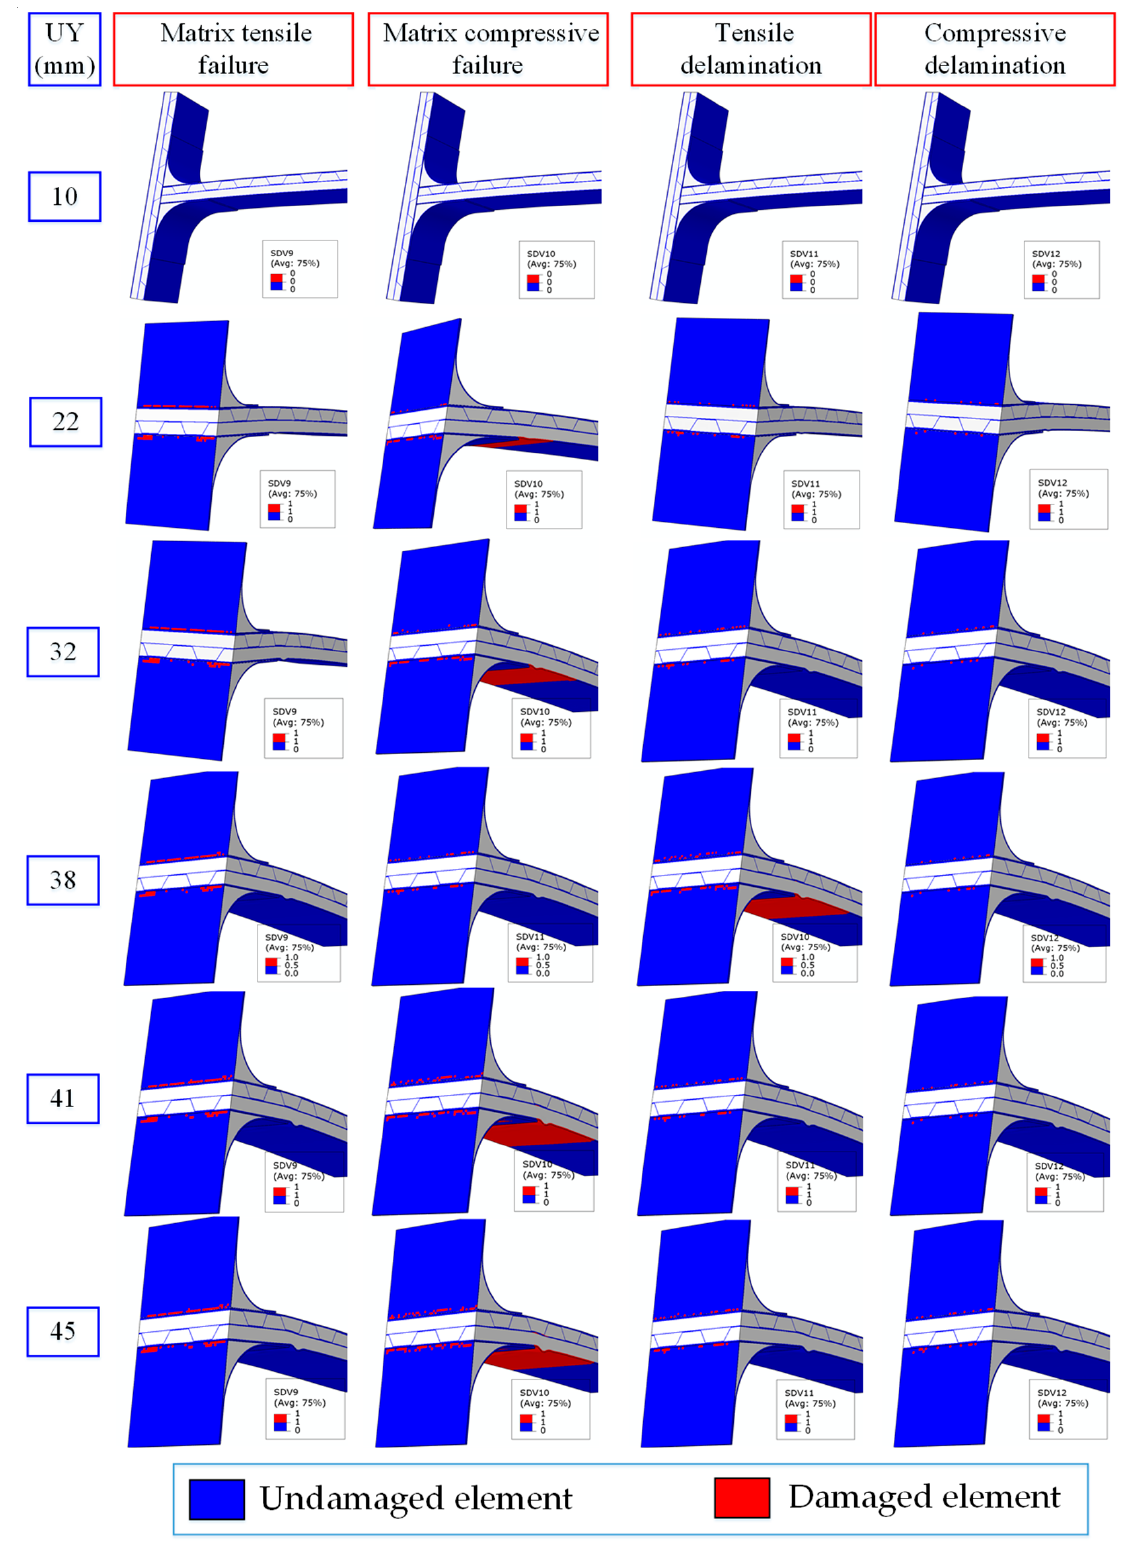
Figure 13. Damage evolution of the T-joint in different failure modes.